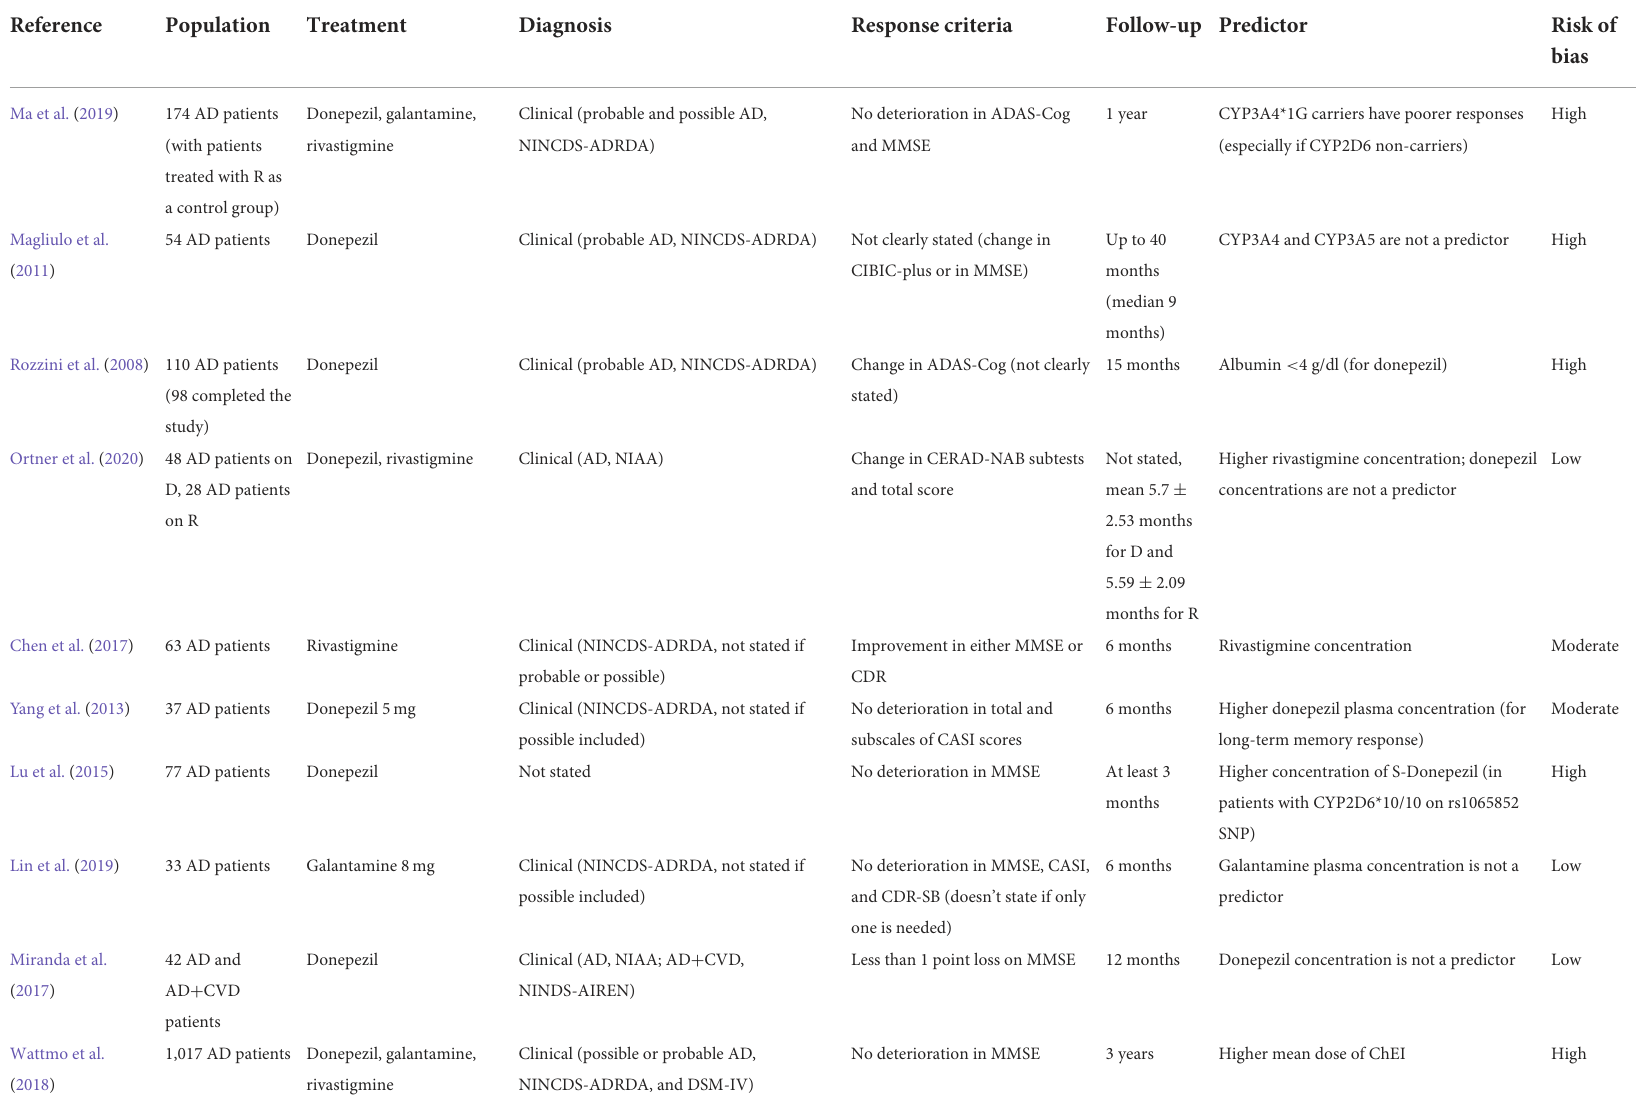
TABLE 4 Other factors involved in drug